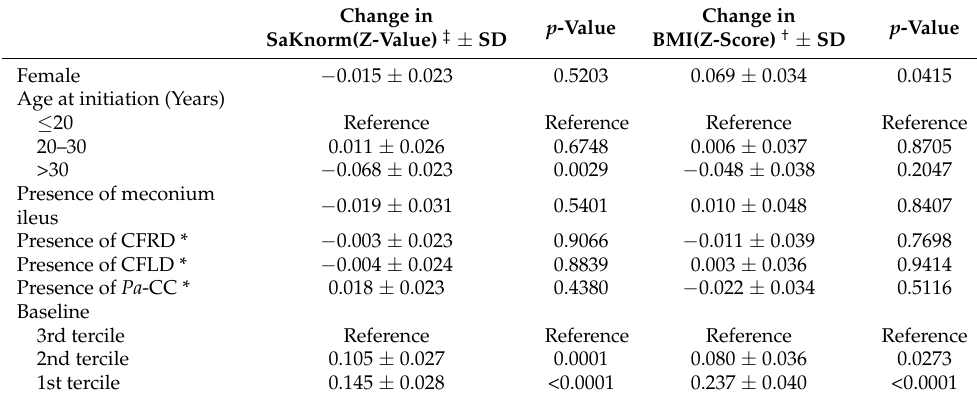
Table 2. Lung function and nutritional response of combined lumacaftor/ivacaftor therapy, according to clinical and demographic characteristics in 765 people with cystic fibrosis.